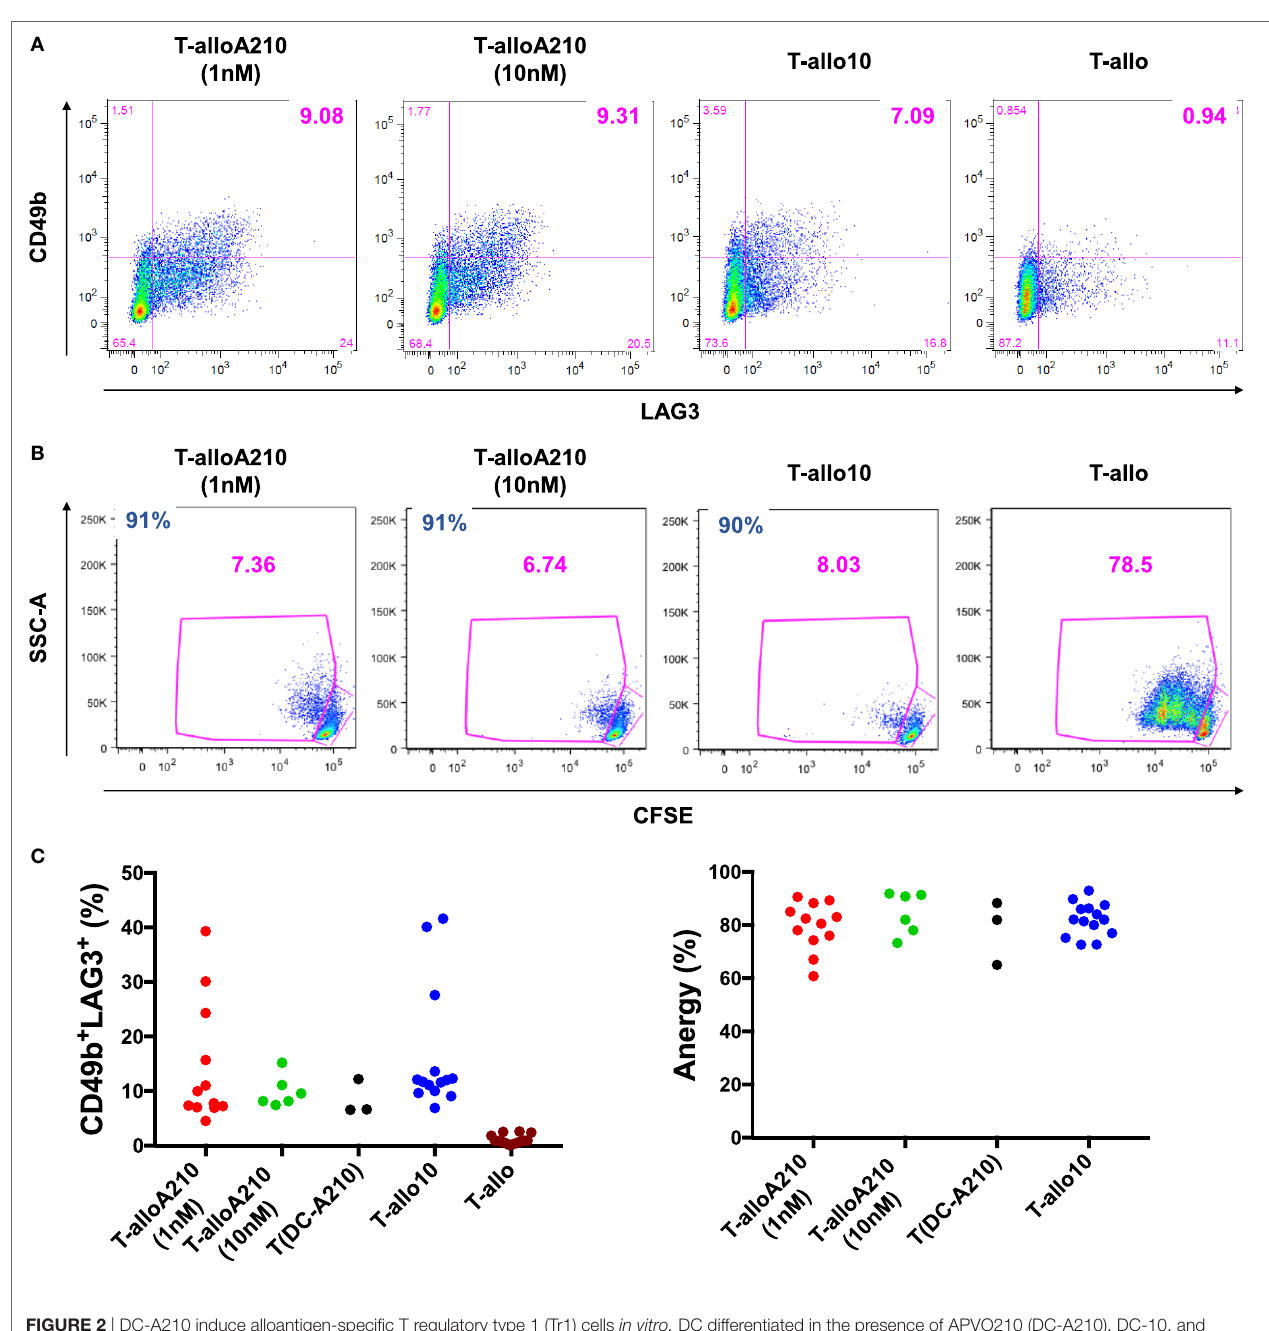
FigUre 2 | DC-A210 induce alloantigen-specific T regulatory type 1 (Tr1) cells in vitro. DC differentiated in the presence of APVO210 (DC-A210), DC-10, and mature DC (mDC) were incubated for 10 days with allogenic CD4 + T cells. (a) The presence of CD49b + LAG3 + Tr1 cells was tested by flow cytometry in T cells cultured with allogenic DC-A210 + APVO210 (T-alloA210: 1 nM, n = 12 or 10 nM, n = 6), with DC-A210 with no addition of APVO210 [T(DC-A210)], with DC-10 + rhIL-10 (T-allo10, n = 14) and with mDC (T-allo, n = 14). Data are shown for a representative donor. (B) Proliferation of T-alloA210, T-allo10, and T-allo cells stained with CFSE and stimulated for 3 days with allogeneic mDC was evaluated by means of CFSE dye dilution using flow cytometry. Percentage of anergy calculated using the formula “(% proliferation T-allo with mDC − % proliferation T-alloA210 or T-allo10 with mDC)/% proliferation T-allo with mDC.” Data of one representative donor are shown, percentage of anergy is indicated in blue. (c) Separate plots for phenotype and anergy are shown. Wilcoxon tests with Bonferroni correction were performed for statistical